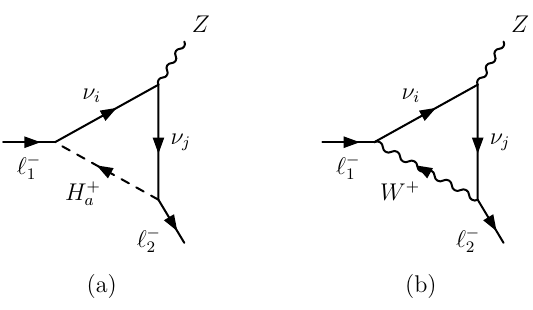
Figure 15 . Two diagrams for Z → ‘ 1+ ‘ 2 − where the Z attaches to two neutrino lines.